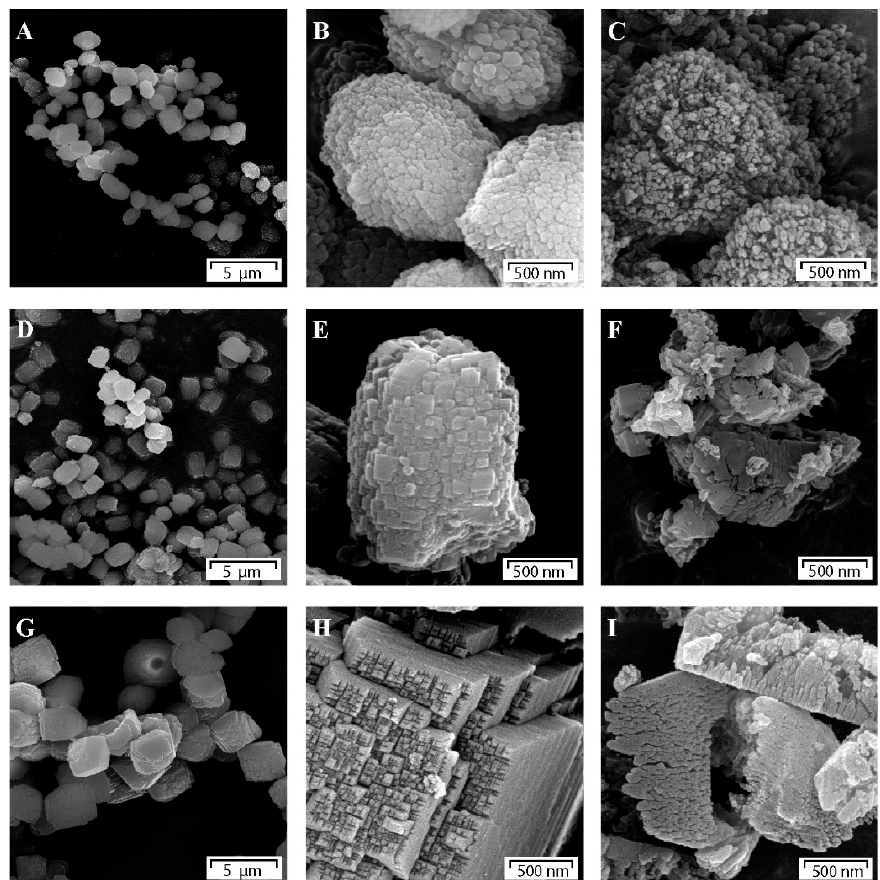
Figure 9. SEM images: ( A ) ZSM-5 standard; ( B ) ZSM-5 standard; ( C ) ZSM-5-at(60); ( D ) ZSM-12-(105) standard; ( E ) ZSM-12-(105) standard; ( F ) ZSM-12-(105)-at(60); ( G ) beta standard; ( H ) beta standard and ( I ) beta-at(120) [106]. Copyright (2011), with permission from Elsevier.